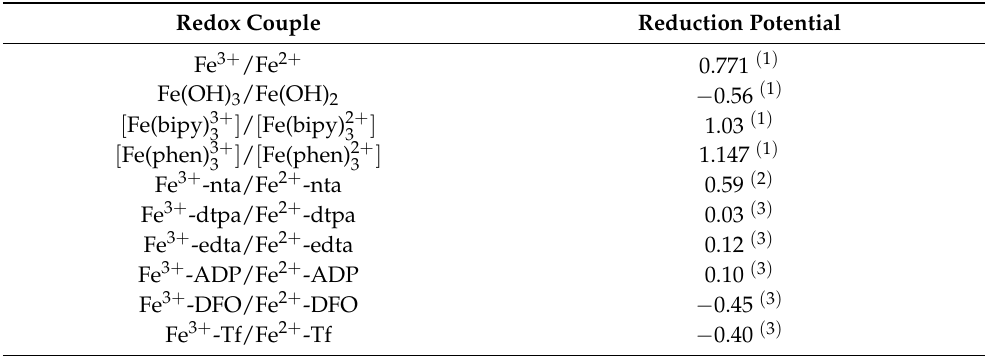
Table 1. Standard reduction potentials for some iron coordinate compounds. (1) ref [21]; (2) ref [22]; (3) ref